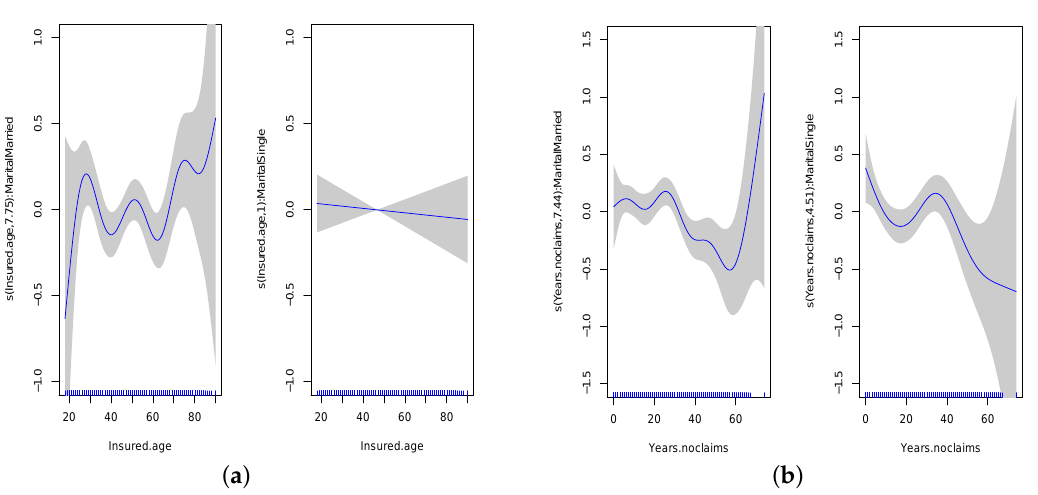
Figure 11. The plots of fitted spline functions for Insured Age and Years of no Claims, separated by Marital Status. ( a ) Insured Age by Marital Status; ( b ) Years of no Claims by Marital Status. Finally, rate relativities for different risk factors are estimated through GLM